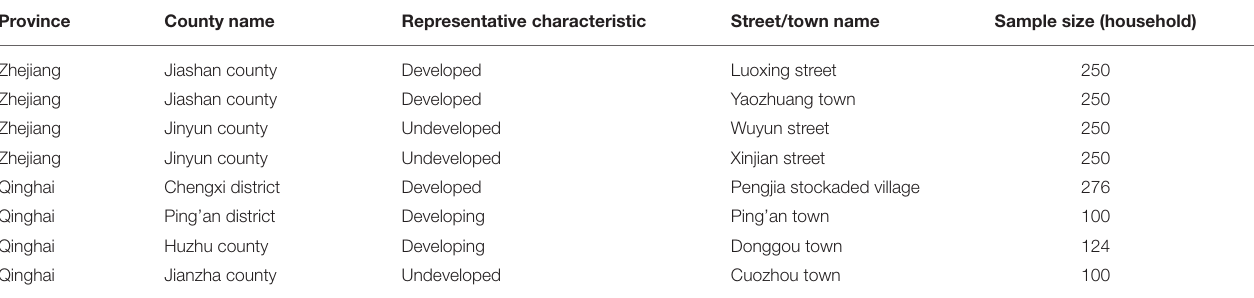
TABLE 1 | Sampling distribution of residents’ health service utilization.